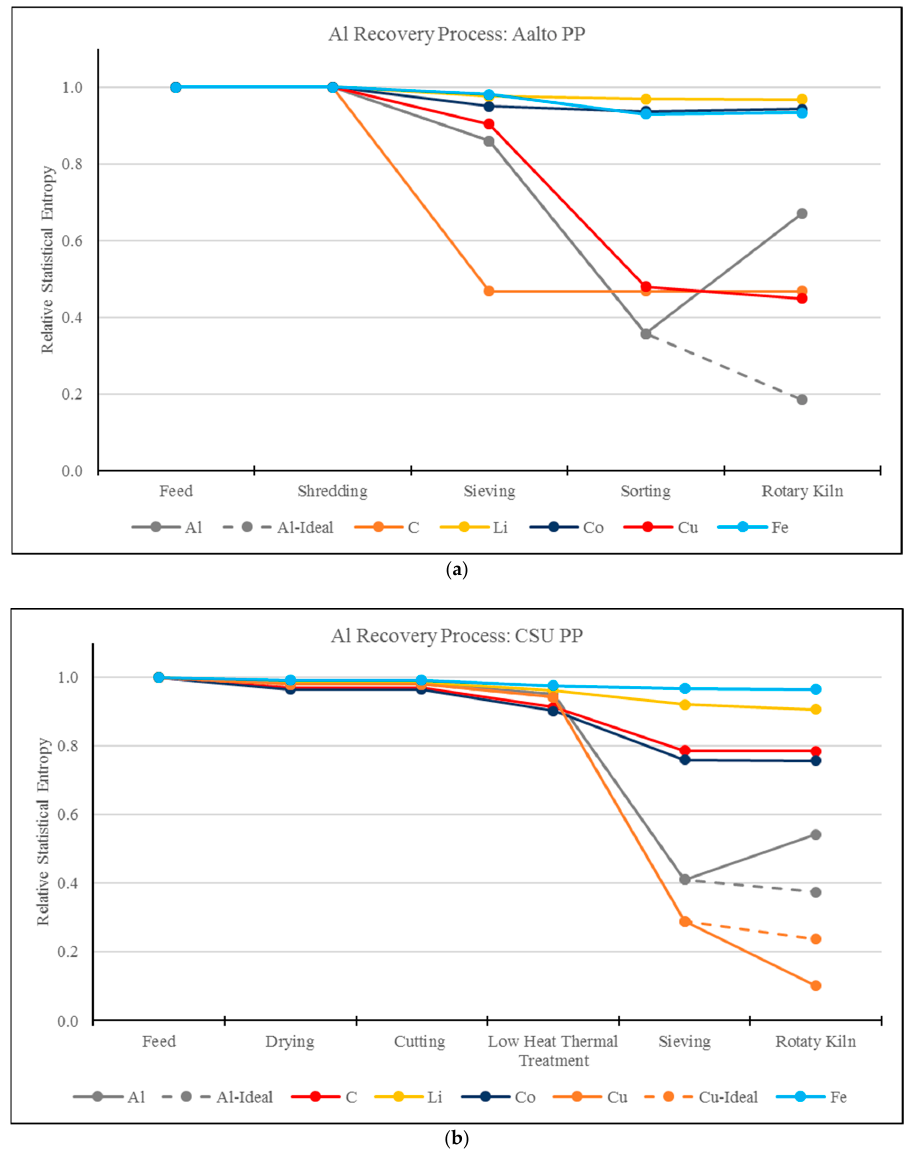
Figure 10. Al recycling Loops. ( a ) Aalto pre-processing (PP), ( b ) Central South University (CSU)